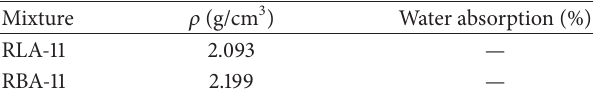
Table 5: Physical